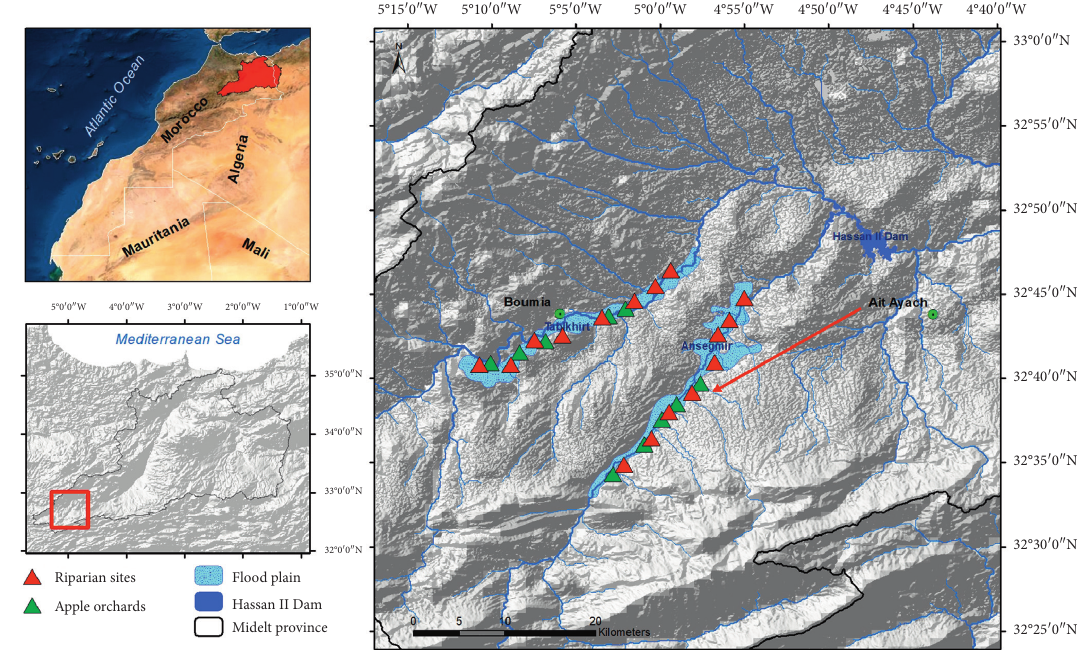
Figure 1: Breeding habitats of the turtle dove in orchards and riparian habitats in Midelt province (Morocco).